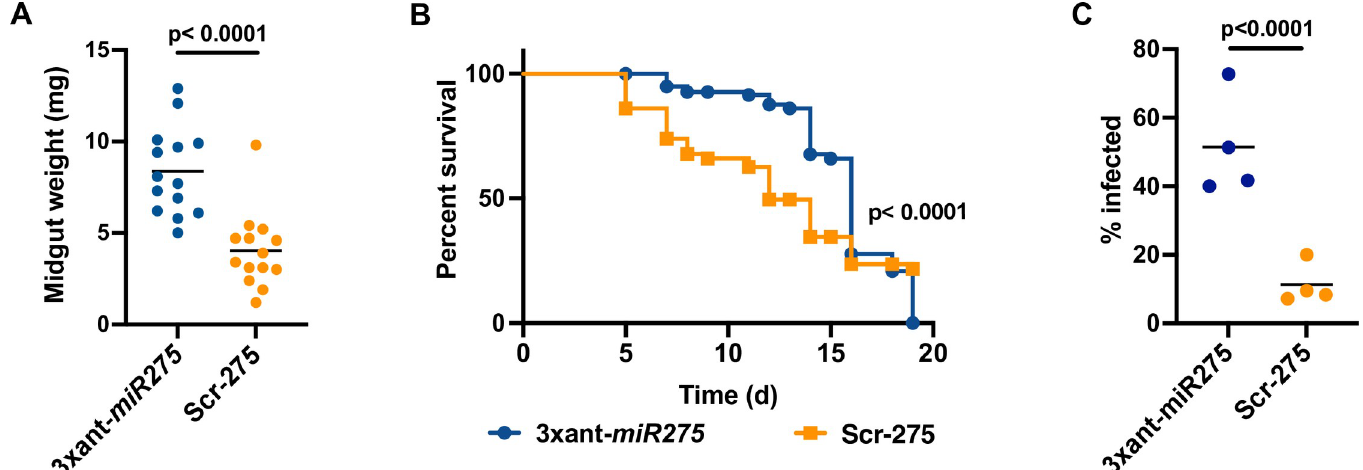
Fig 2. Gut physiological homeostasis is compromised in Gmm 3xant- miR275 . (A) Tsetse gut weights. The gut weights were measured 24 h after the last blood meal. Each dot represents an individual fly gut. Mann-Whitney test was used for statistical analysis. (B) Serratia infection assay. A total of 4 biological replicates ( n = 25 flies per replicate) were used. Gehan-Breslow-Wilcoxon test was used to determine statistical significance. (C) Trypanosome midgut infection prevalence. Four biological replicates (n = 20 flies per replicate) were used. Generalized linear model (GLM) with binomial distribution was used to determine statistical significance.